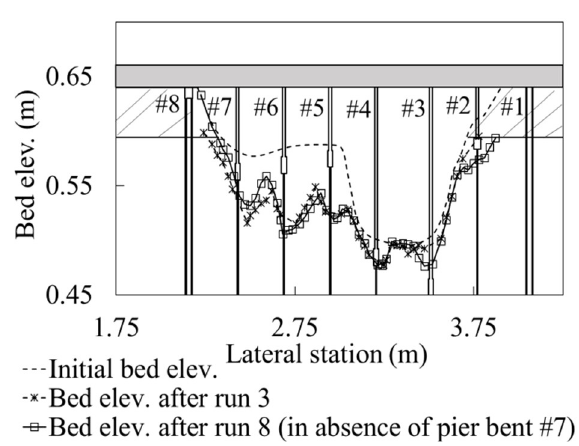
Figure. 6 Comparison of cross-sections for runs 3 and 8. Figure 6. Comparison of cross-sections for runs 3 and